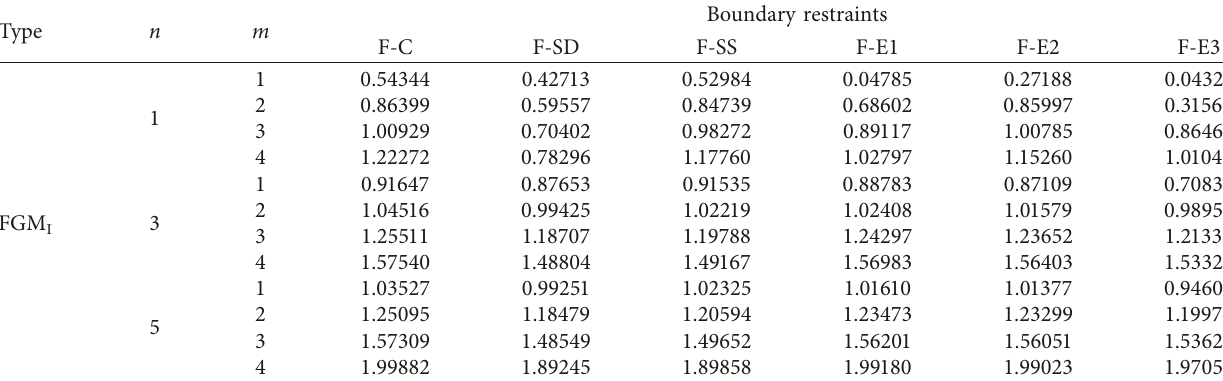
Table 5: Frequency parameters